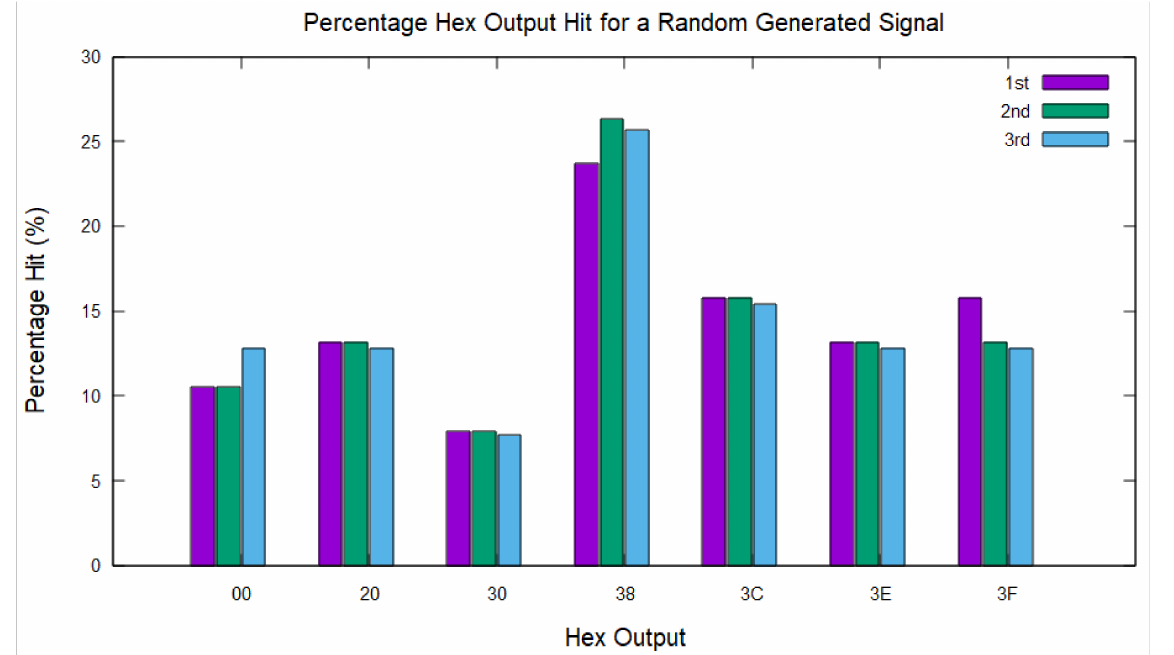
Figure 14. Percentage hex output hit for the random generated signalfor three experiment repetitions.